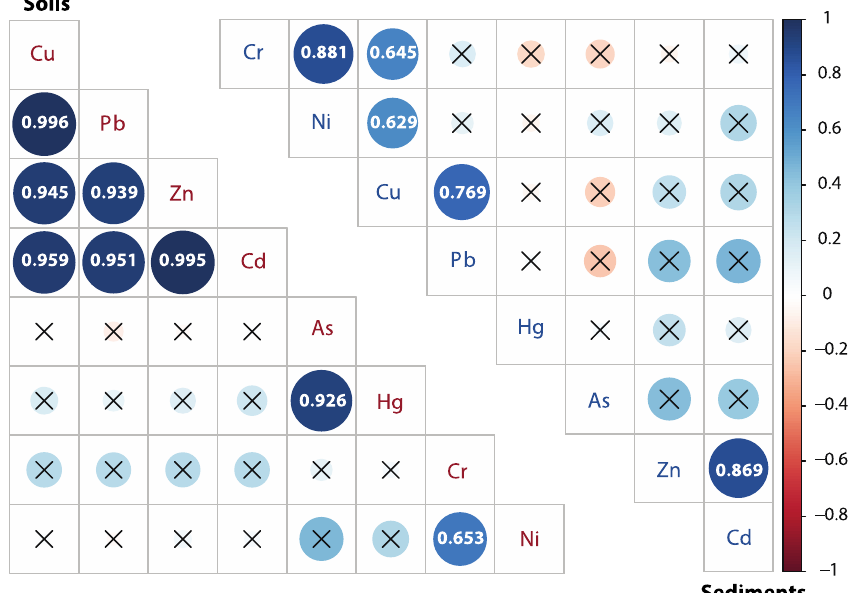
Figure 4. Pearson’s correlation analysis of PTE concentration in soils ( Left ) and sediments ( Right ) inside the mining area.